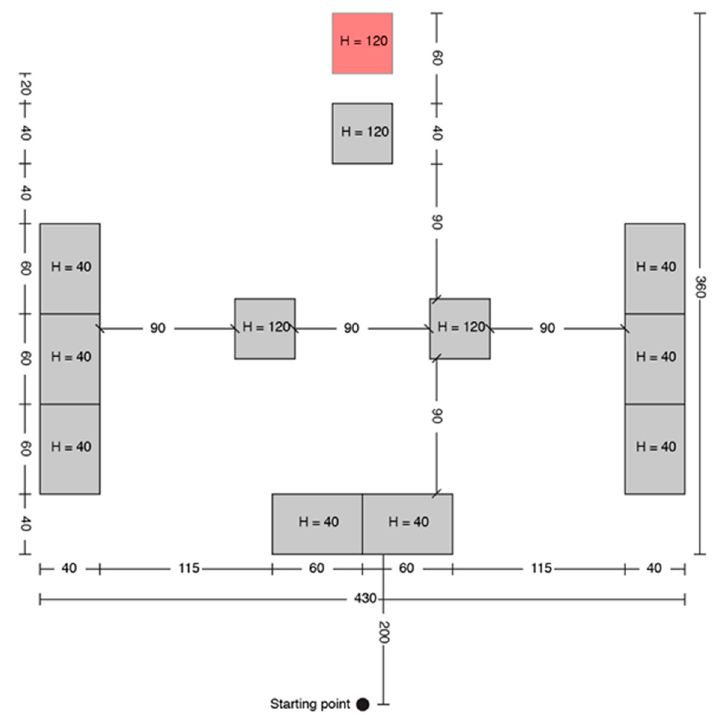
Figure 6. TH configuration B.